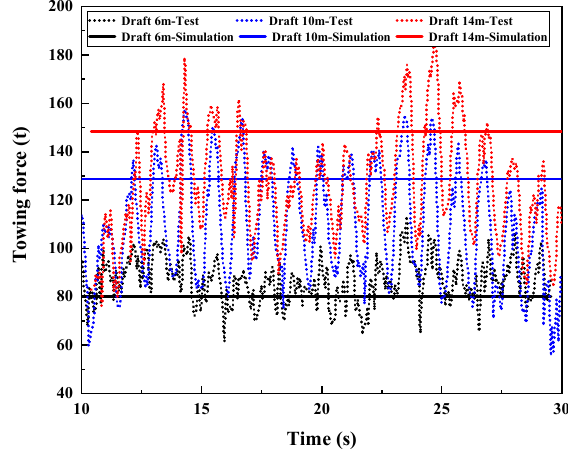
Figure 16. Comparison of test and simulation of towing force.